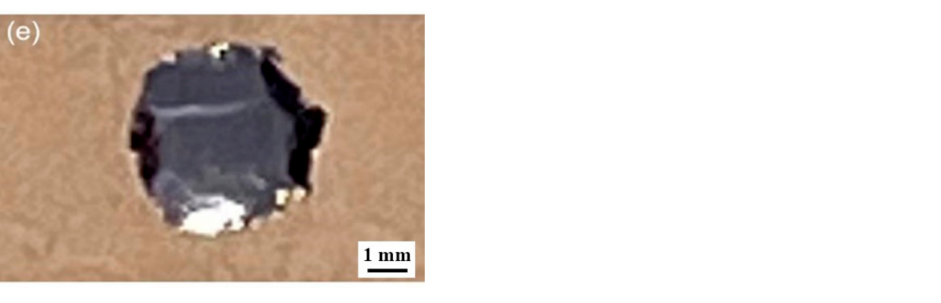
Figure 1. Spreading morphologies of Au-20Sn solders with different oxygen contents on the Cu plate: